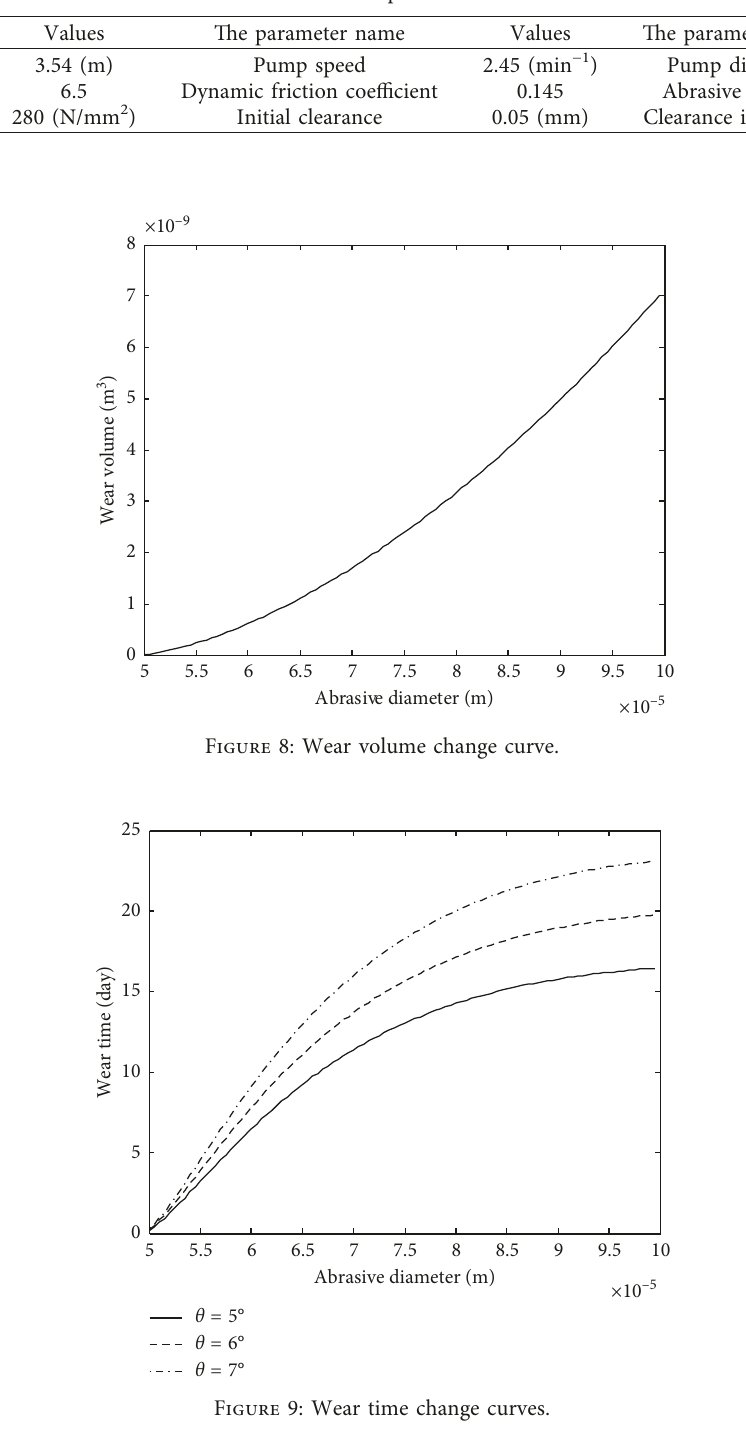
Table 1: Simulation parameters of wear.